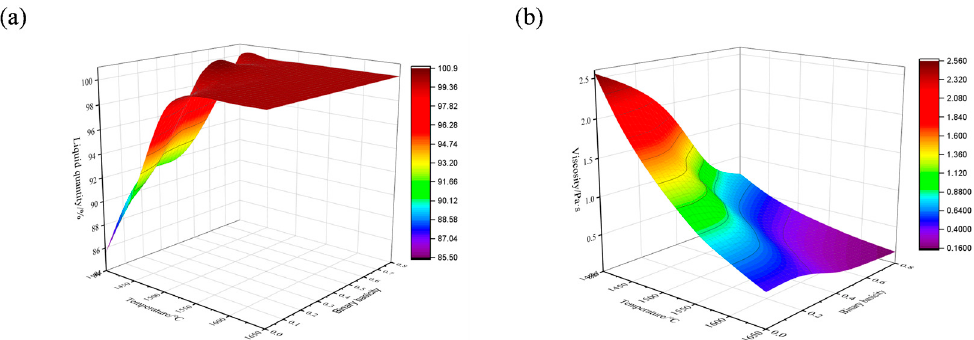
Figure 9. E ff ects of temperature on the mass fraction of liquid phase and viscosity. ( a ) E ff ects of temperature on the liquid quantity; ( b ) E ff ects of temperature on the viscosity (liquid phase quantity represents the mass fraction of liquid